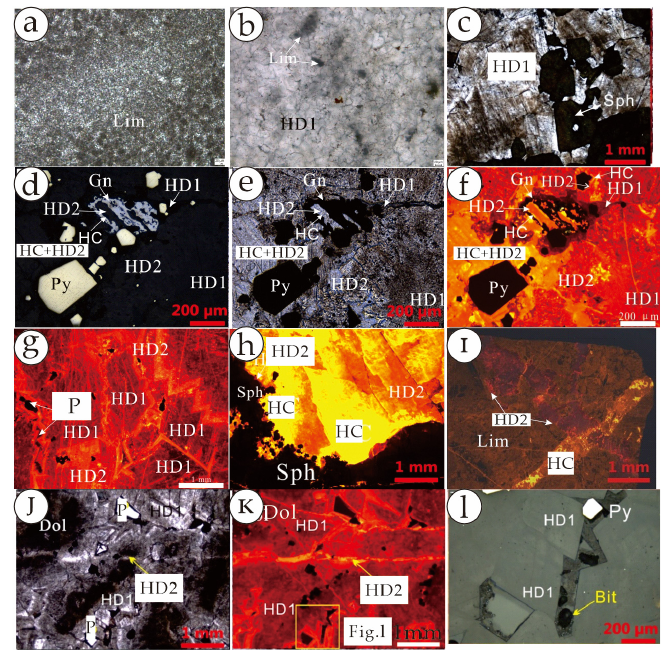
Figure 6. Dolomitization characteristics of the Huize lead–zinc deposit and its relationship to sulfide mineralization. Lim: limestone; ( a – c , e , j )Transmission light micrograph;( d , j )reflection photomicrograph;( f – i , k )cathodoluminescence(CL) photo;Sph: sphalerite; Gn: galena; Py: pyrite; Bit: bitumen; HD1: pre-mineralization dolomite; HD2: hydrothermal dolomite during mineralization; HC: Hydrothermal calcite formed after mineralization; P: pore.